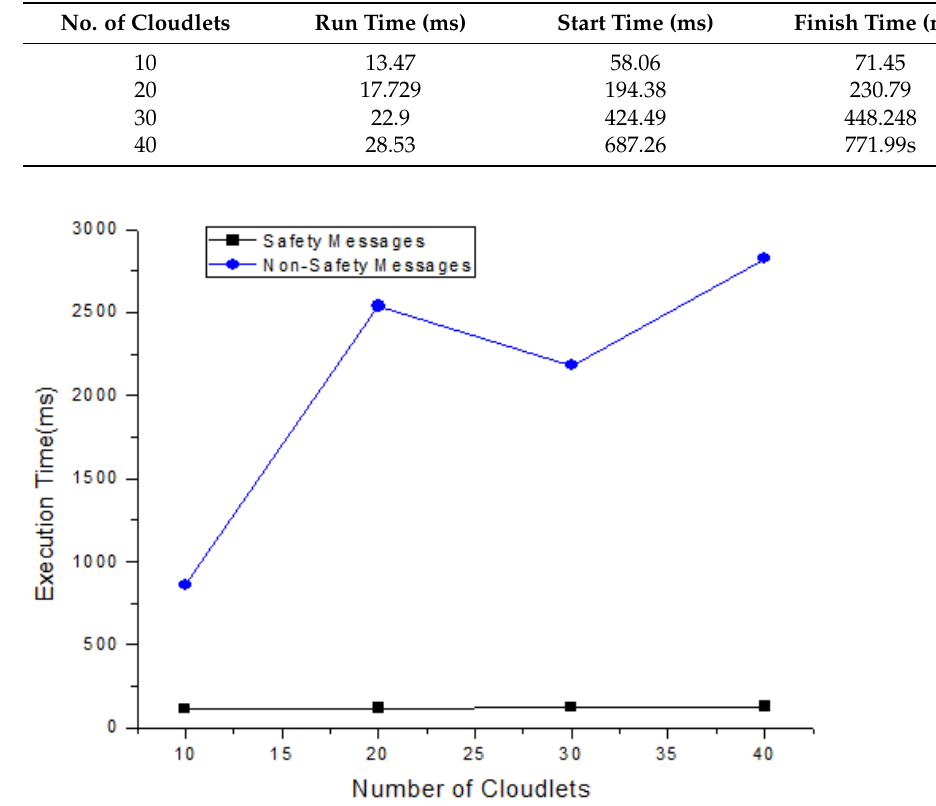
Figure 6. comparison of calculated execution time for safety messages and non-safety